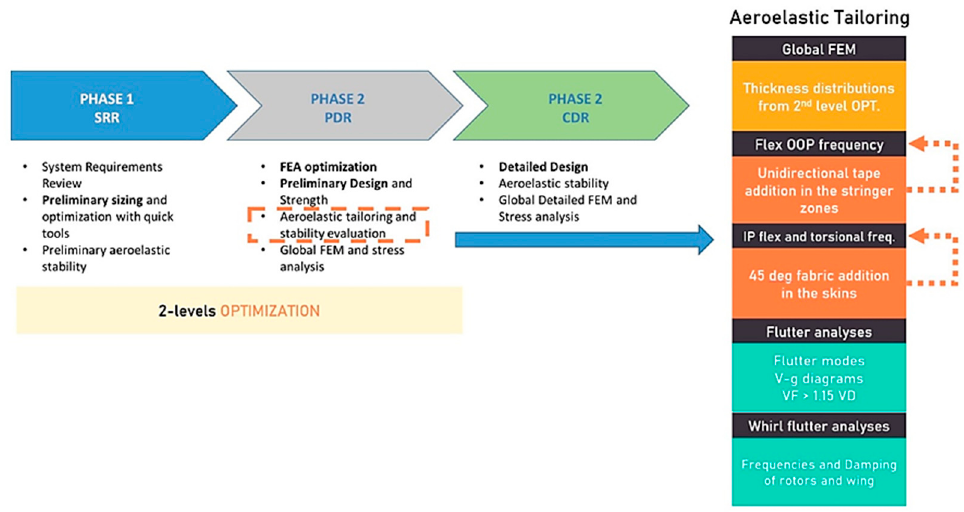
Figure 1. T-WING design and aeroelastic tailoring phases.